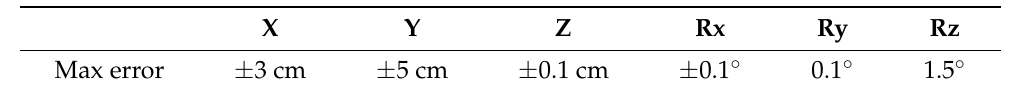
Table 1. Scan matching